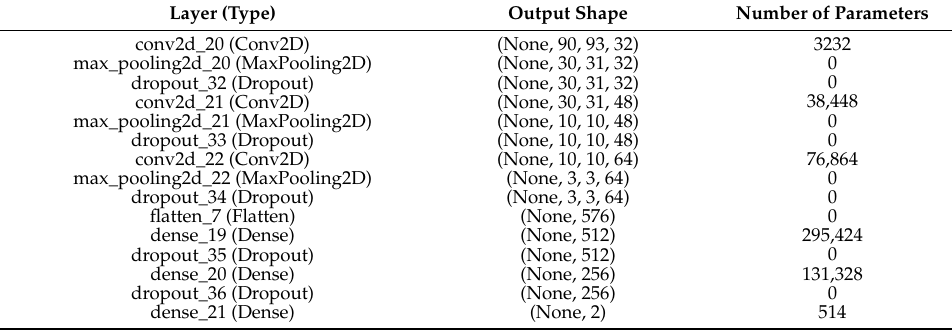
Table 7. Model of the network used in Experiment